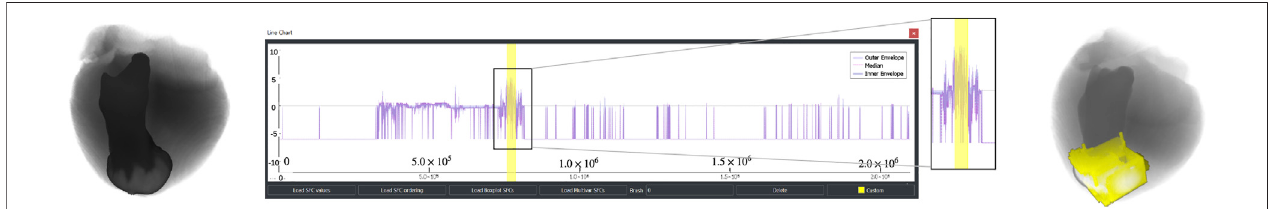
FIGURE 5 | Functional box plots applied to a data-adaptive space- fi lling curve. The volume rendering on the left shows the median of a heart ischemia simulation. The center part shows the variability in the input along the horizontal axis that corresponds to a space- fi lling curve cutting through the volume. Here, the user can select (brush) ranges ofinterestsuch asan area where the potential value islarger than 3 eV. The corresponding ischemic region is highlighted (yellow) inthe volumerendering on the right. Image: © 2021 IEEE. Reprinted, with permission, from Zhou et al.